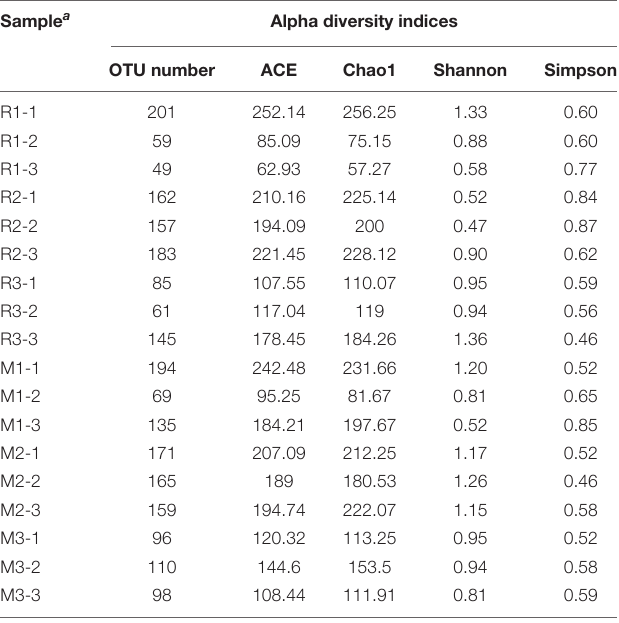
Sample a Alpha diversity indices OTU number ACE Chao1 Shannon Simpson